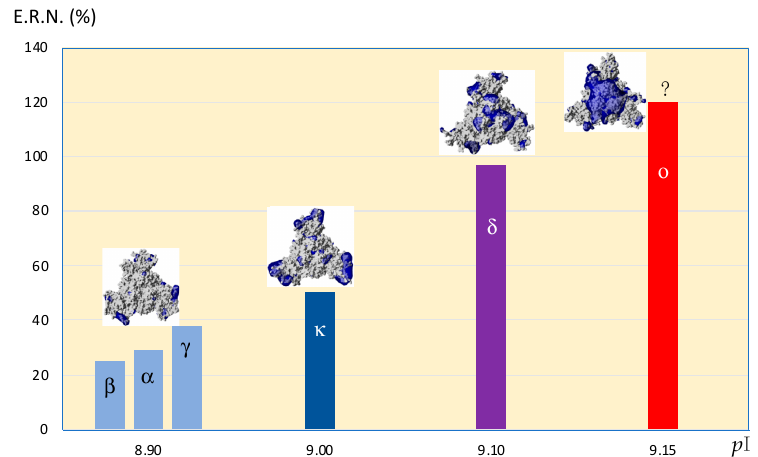
Figure 4. Figure illustrating the relationship between the increasing effective reproduction number (E.R.N.) of the α , β , γ , κ , δ and o variants of concern and their increasing isoelectric point ( p I) values. Mapping of electropositive potentials (blue) on the molecular surface of the VOC is represented. The E.R.N. of omicron variant was arbitrarily fixed at +120% because it is too early to have an accu- rate estimation of its E.R.N., especially in Europe and in USA (?).